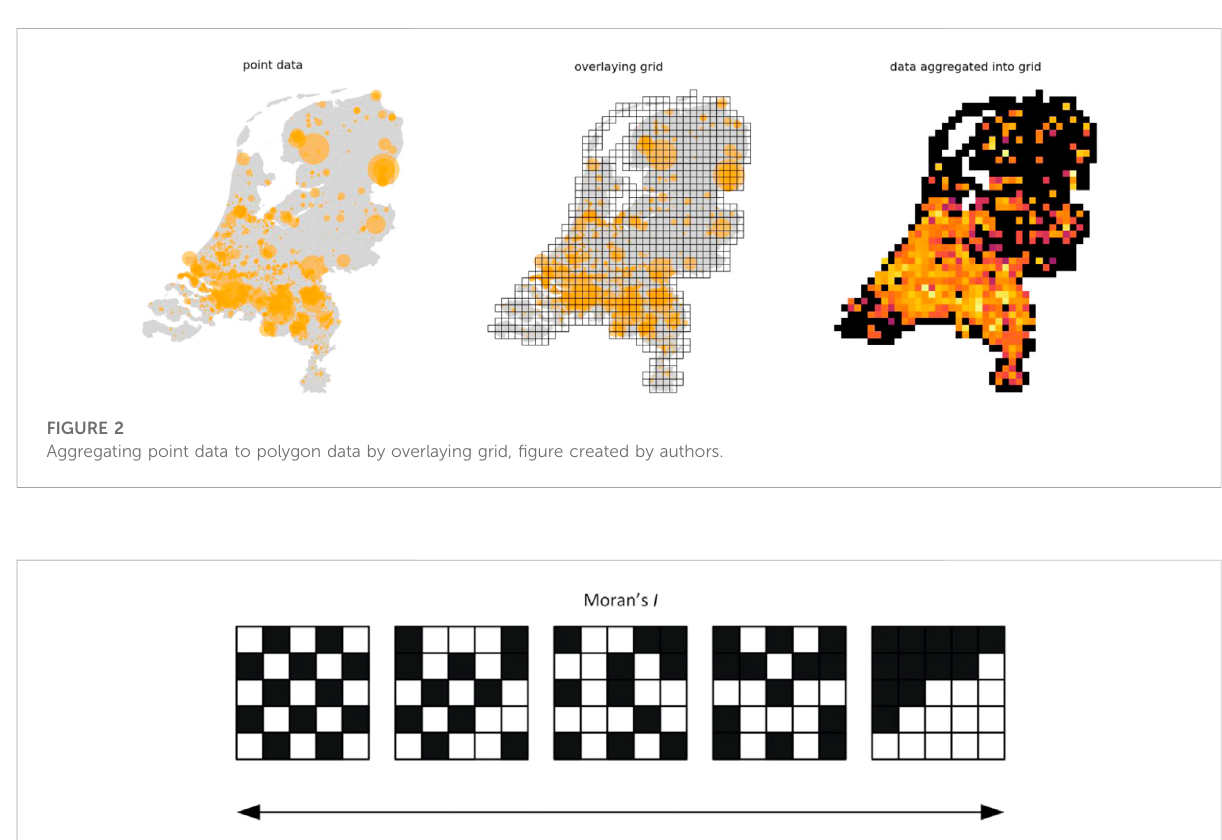
Frontiers in Built